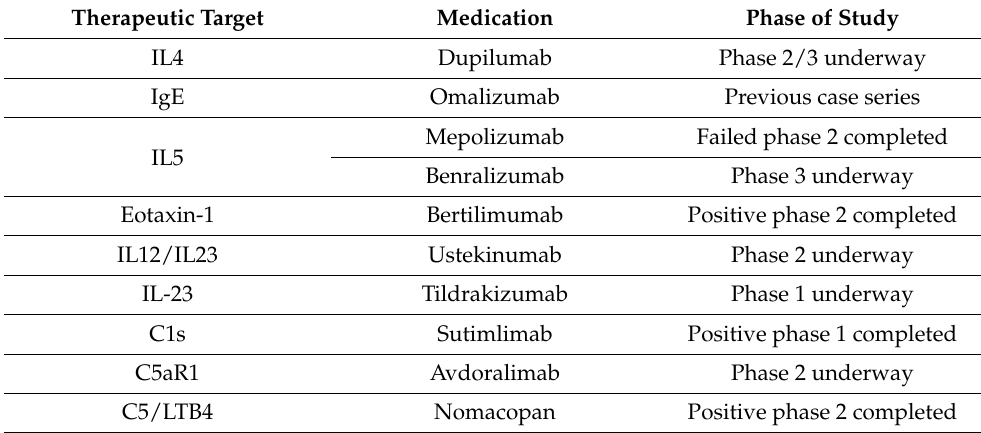
Table 1. Targeted therapies currently under investigation for use in